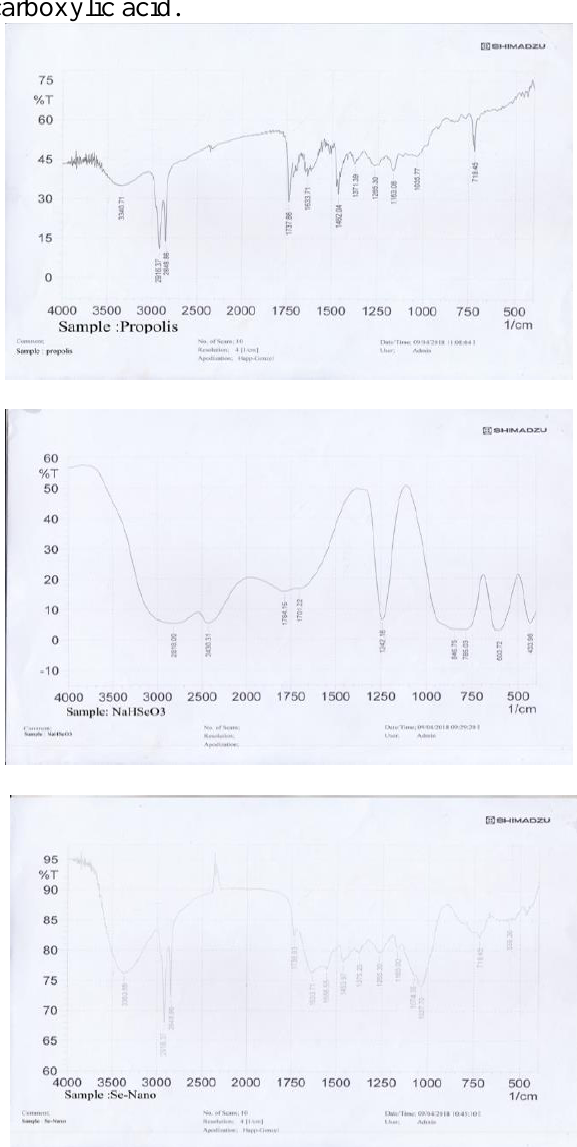
Figure, 3: FTIR spectrum illustrates the functional groups of propolis, NaHSeO3 and Se -Nano particles. The result of the analysis of the SEM micrographs represented in (Fig.4). Images showed accumulation